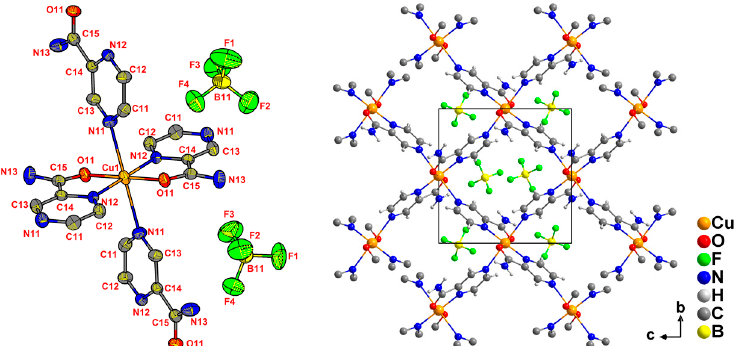
Figure 3. ORTEP representation (50% probability level) of the molecular entity within the structure of 2 ∞ [Cu(Pya) 2 ](BF 4 ) 2 ( 9 ) ( left ); packing along the a axis in the crystal ( right ); H atoms were omitted for clarity.